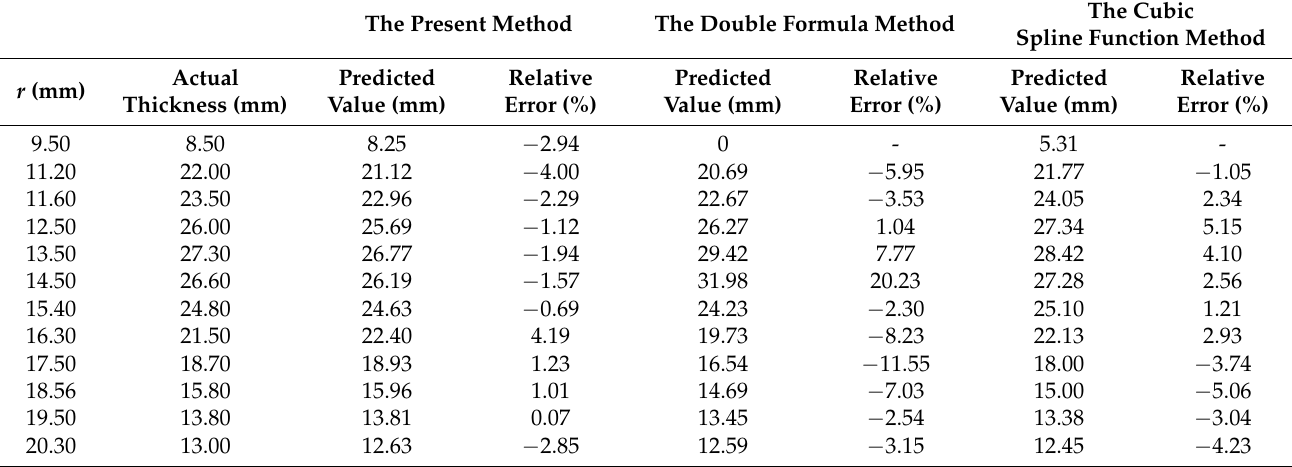
Table 2. Relative error between the analytical results and the measurement